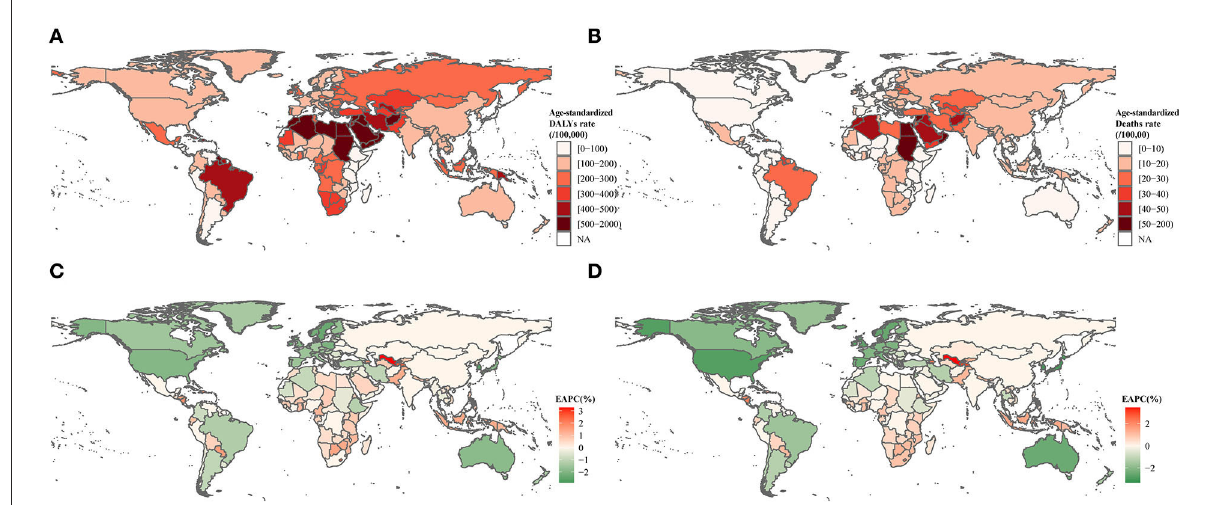
FIGURE1 Age-standardized DALYs and death rates in 2019, EAPCs in age-standardized DALYs, and death rates from 1990 to 2019 for DALPA. (A) Age-standardized DALYs of DALPA in 2019. (B) Age-standardized death rates of DALPA in 2019. (C) EAPCs in age-standardized DALYs from 1990 to 2019. (D) EAPCs in age-standardized death rates from 1990 to 2019.